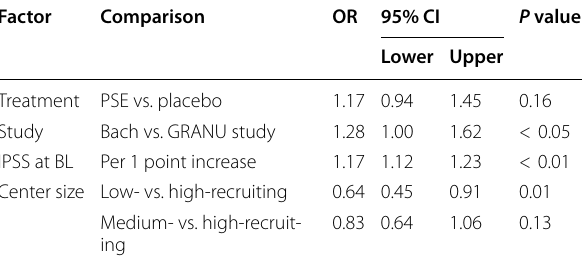
PSE pumpkin seed soft extract, BL baseline